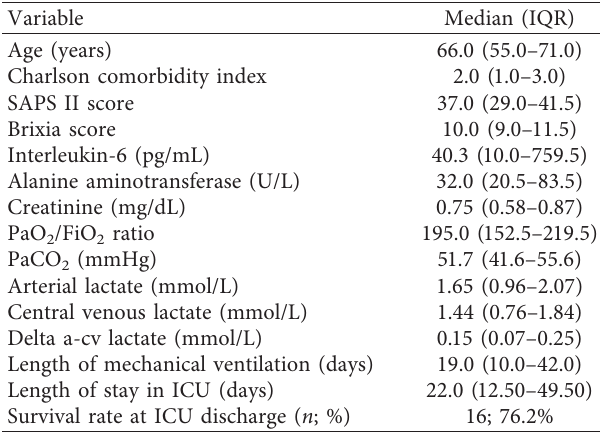
Table 1: Baseline characteristics on ICU admission and ICU outcomes of the enrolled population.